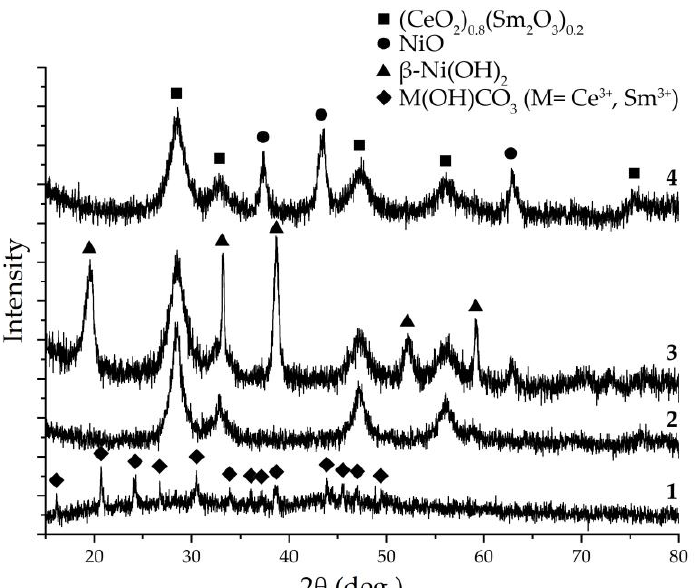
Figure 2. X-ray diffraction patterns of M(OH)CO 3 (M = Ce 4+ ; Sm 3+ ) ( 1 ), (CeO 2 ) 0.8 (Sm 2 O 3 ) 0.2 ( 2 ), ((CeO 2 ) 0.8 (Sm 2 O 3 ) 0.2 )@β -Ni(OH) 2 ( 3 ), and ((CeO 2 ) 0.8 (Sm 2 O 3 ) 0.2 )@NiO ( 4 ) powders after drying ( 1 and 3 ) and additional heat treatment ( 2 and 4 ).